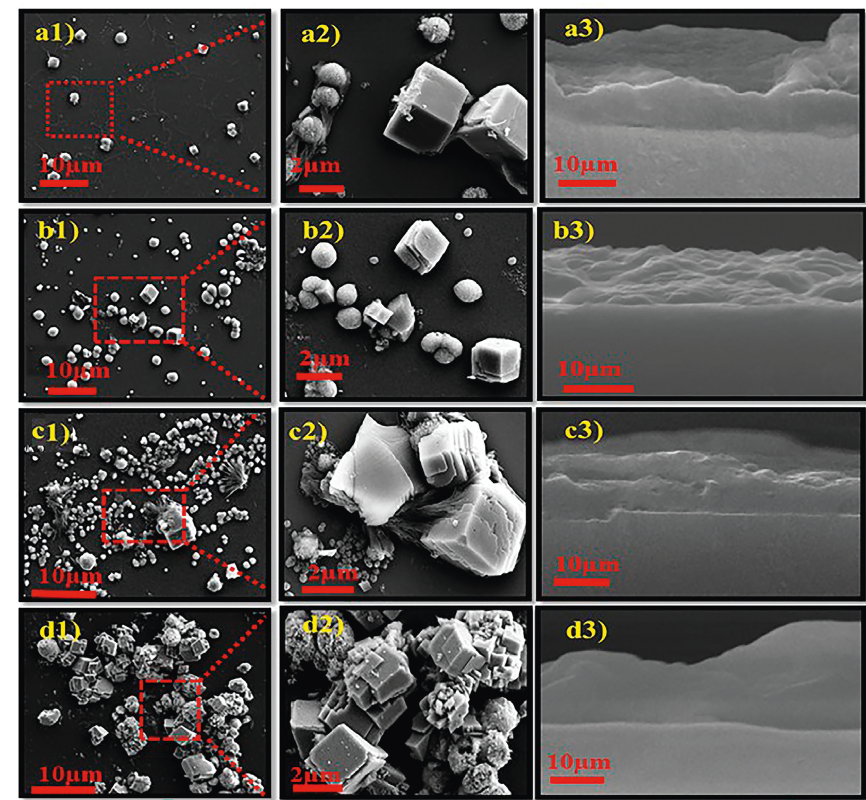
Figure 2: SEM images of calcium carbonate of (a1–a3) noncross-linked, (b1–b3) low cross-linked, (c1–c3) medium cross-linked, and (d1–d3) highly cross-linked (PAH/PAMAM) 7.5